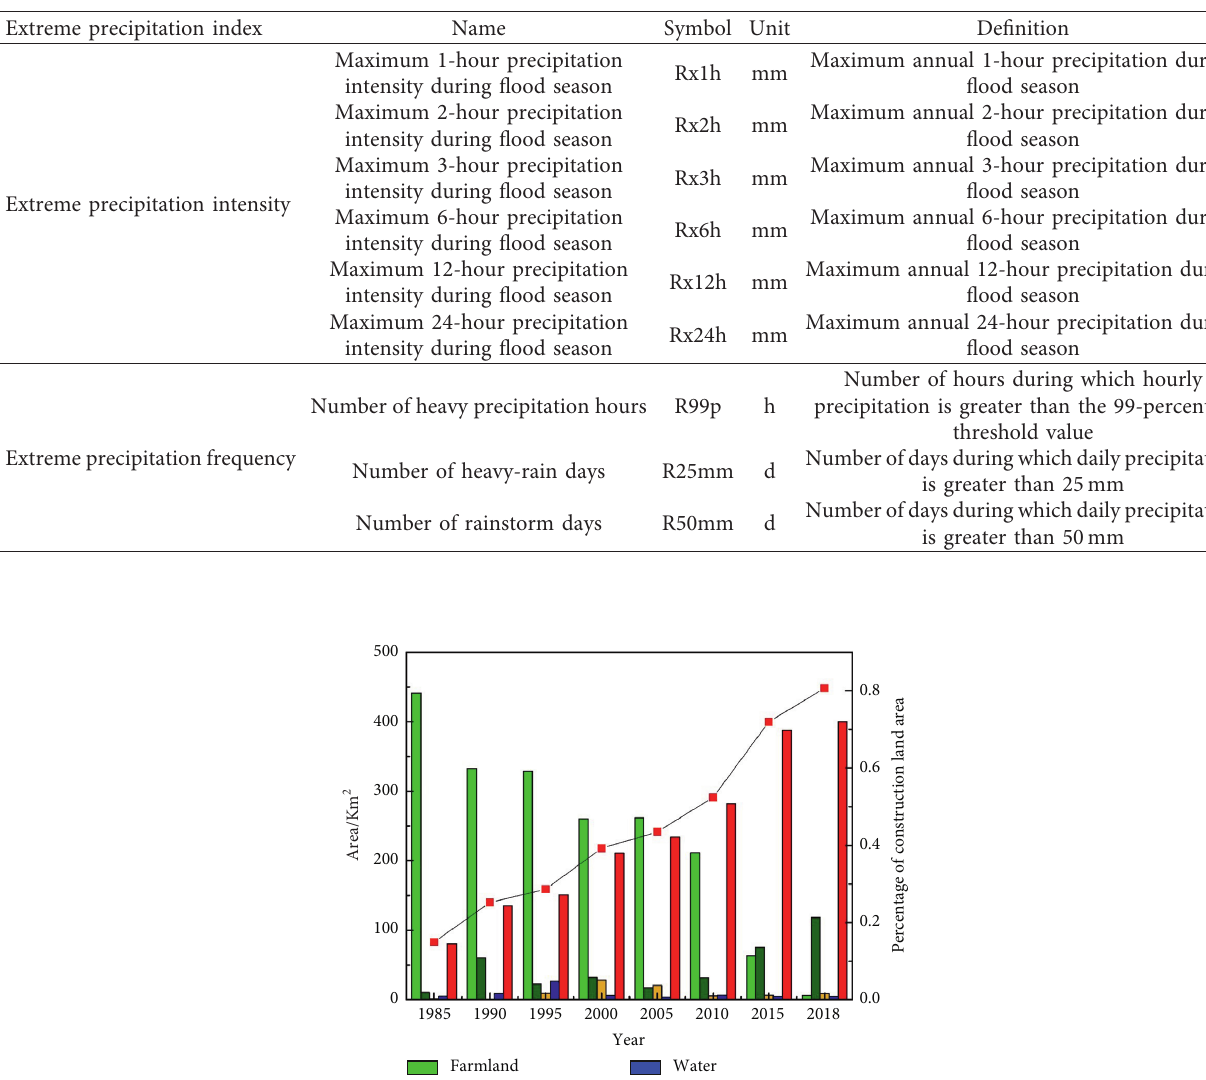
Table 1: Indices for extreme precipitation events and their definitions.